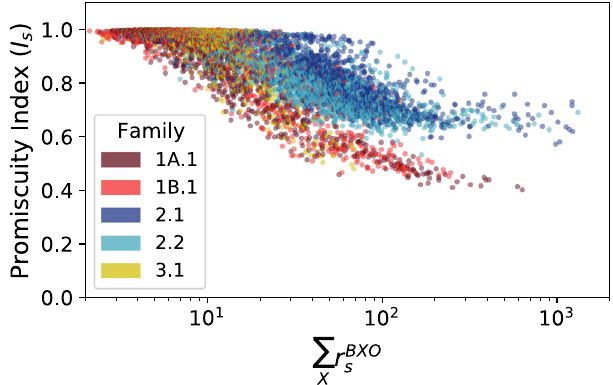
Fig. 4 Relationship between activity and promiscuity. Promiscuity index values for each sequence as a function of total activity (sum of activities with all tested substrates). The general trend indicates that speci fi city increases (promiscuity decreases) as overall activity increases. Source data are provided as a Source Data fi le.